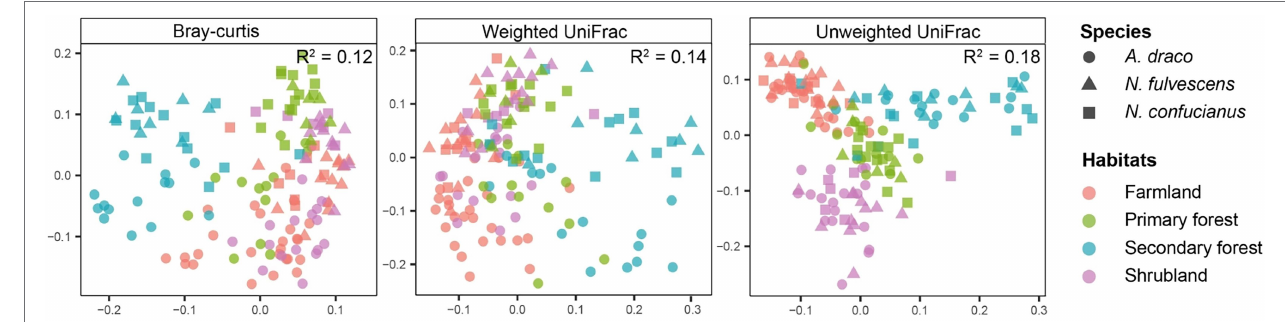
FIGURE 5 | Constrained principal coordinates analysis plots showing how clustering of samples by habitats varies across three dissimilarity metrics that differ in their sensitivity to the phylogenetic relatedness and abundance of bacterial sequence variants. R 2 values from permutational multivariate ANOVAs (PERMANOVAs) testing the effect of habitats are shown on each plot.